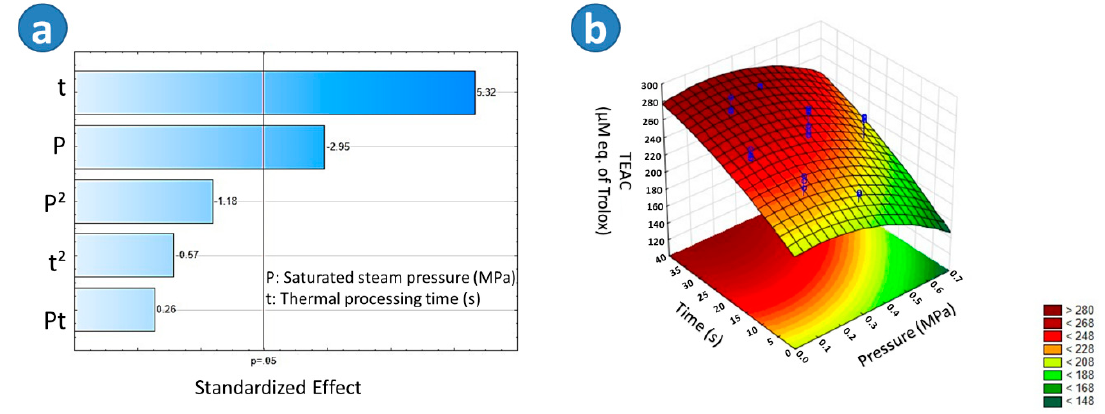
Figure 5. Effects of steam pressure “P” (MPa) and thermal processing time “t” (s) on the Trolox equivalent antioxidant capacity (TEAC) of Blanched Swell-Dried (BSD) red beetroots. ( a ) The Pareto chart and ( b ) surface response plot are shown.